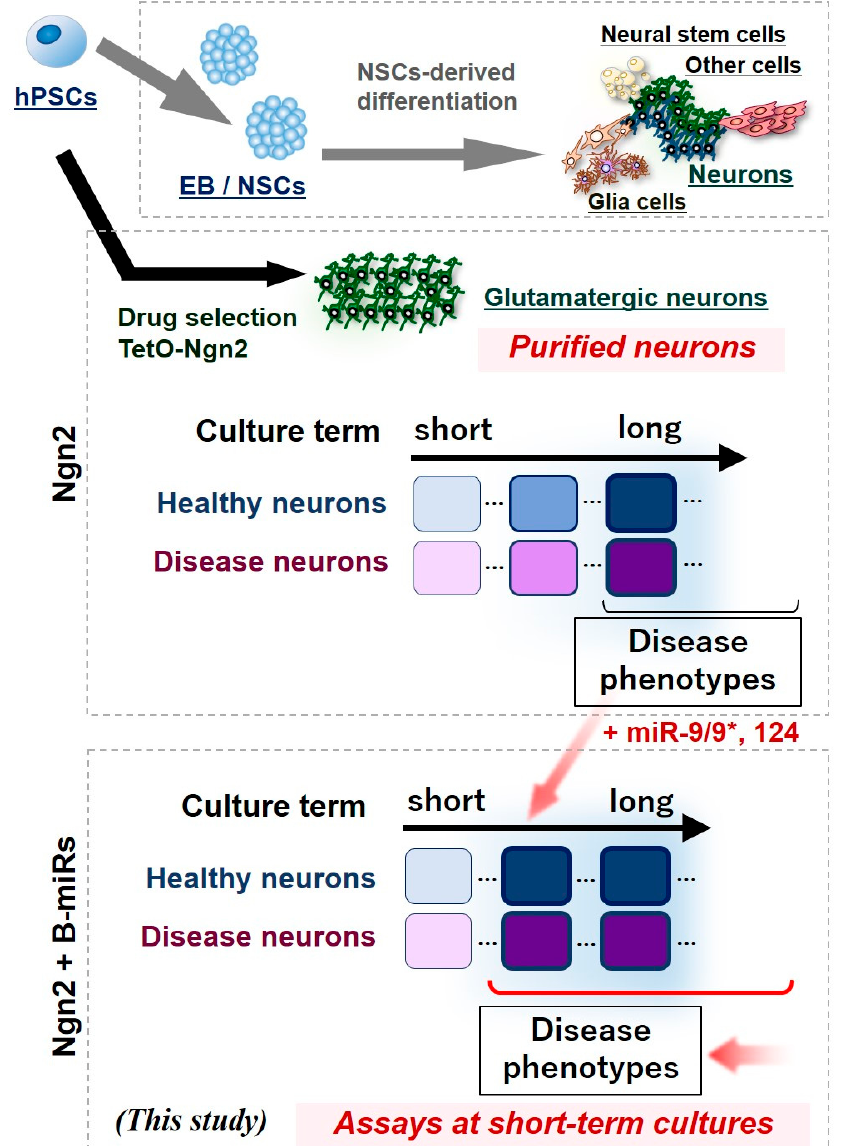
Figure 7. Accelerated pathological analysis and drug discovery screening resulting from early neural differentiation and maturation from pluripotent stem cells by combining the expression of Neurogenin2 and microRNA-9/9*-124. In contrast to the conventional induction method using dual SMAD inhibitors, transient expression of Ngn2 gene enables a purified population of neurons to be obtained. On the other hand, the Ngn2 method is insufficient in terms of neuronal maturation. Thus, by adding BmiRs expression used in this study, neuronal function can be rapidly enhanced. This enables phenotypic evaluation, which originally required long-term culture, to be performed within short-term culture.